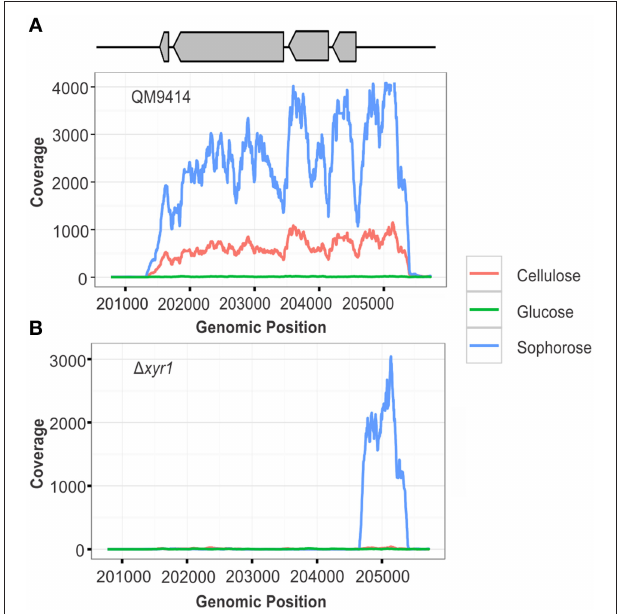
FIGURE 1 | RNA-seq coverage plots of the xyr1 gene. Number of sequence reads (x-axis) along the genomic region corresponding to the xyr1 gene (Protein ID 122208, scaffold 11, genomic position